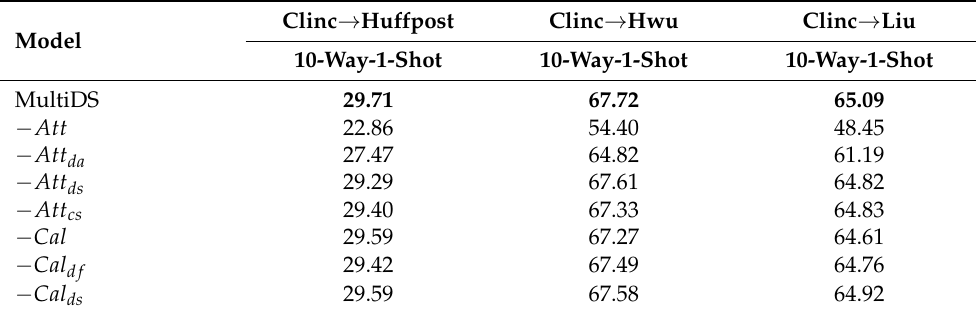
Table 6. Ablation studies on Clinc → Huffpost, Clinc → Hwu and Clinc → Liu. The best results are emphasized using bold fonts.